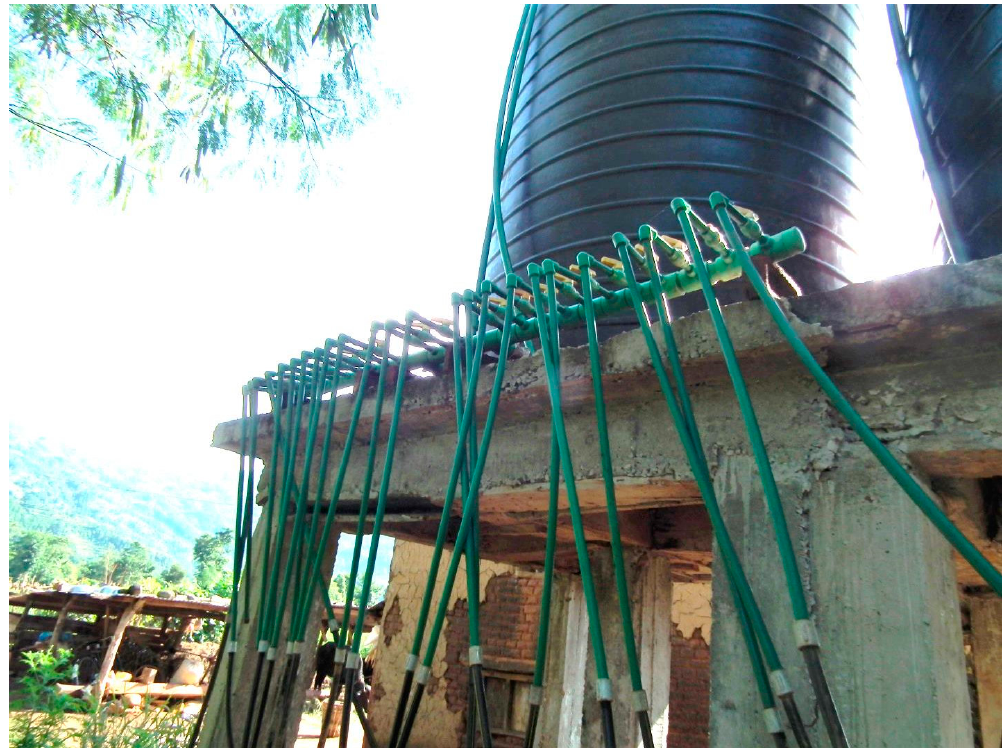
Figure 3. Photo of a community managed water supply tank (with a number of pipes connected to it for distribution to local households).